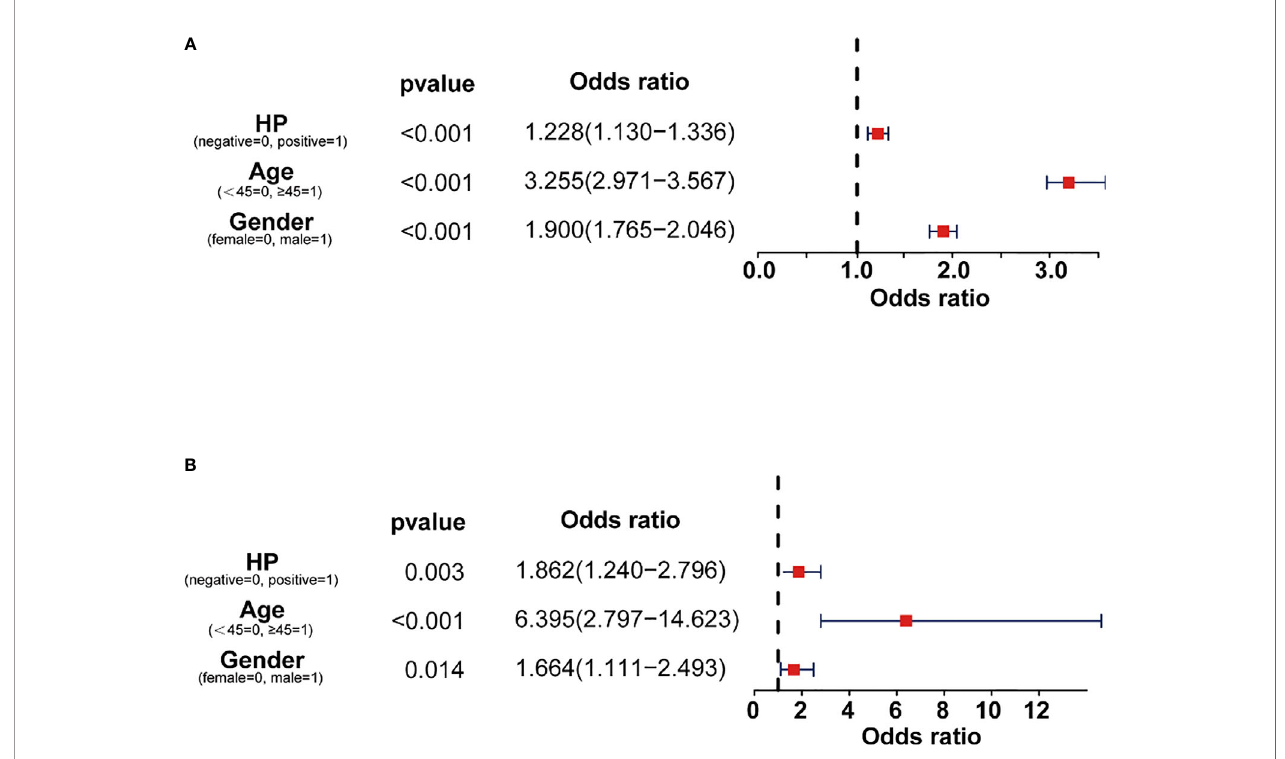
FIGURE 2 | OR value of Hp infection from logistic regression. (A) OR value of gender, age, and Hp for CPs. (B) OR value of gender, age, and Hp for CRC.